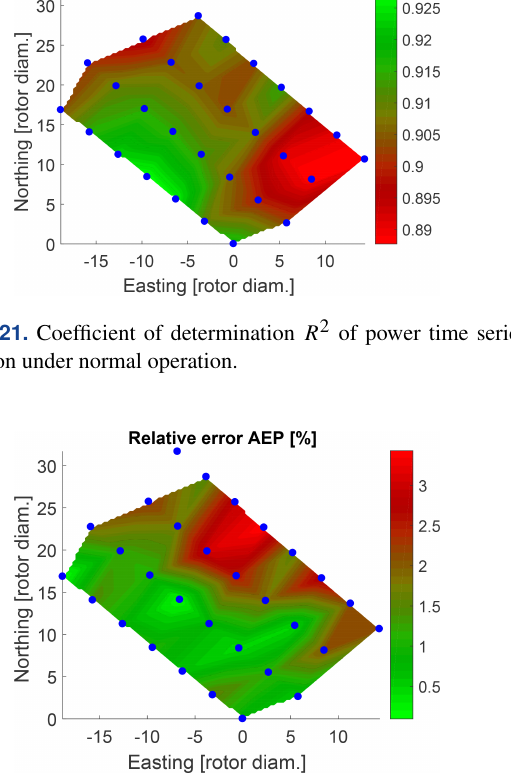
Figure 22. Relative error between measured AEP from SCADA data and estimated AEP within wind